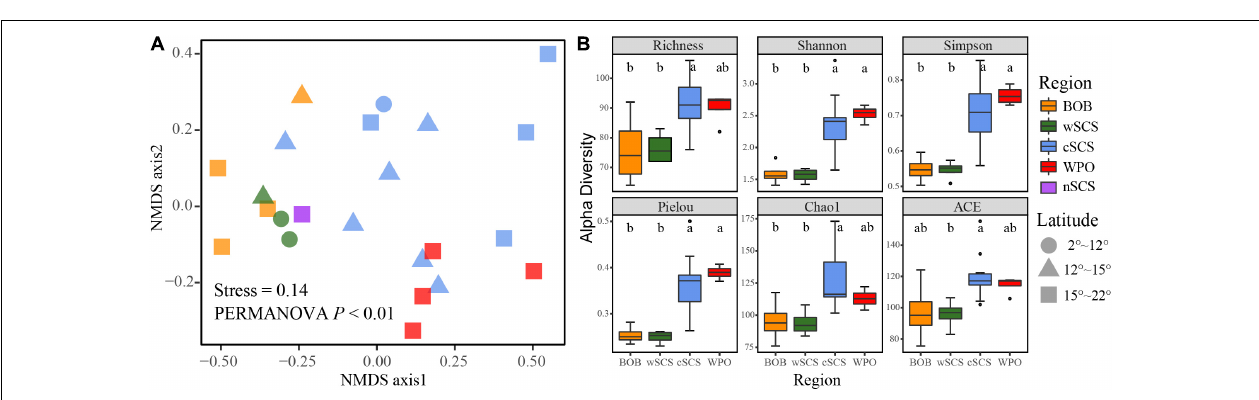
FIGURE 1 | The biogeography and diversity of UCYN-A in the BOB, SCS, and WPO. (A–C) are based on the amplicon dataset. (A) Phylogenetic relationship of dominant OTUs belonging to UCYN-A1, UCYN-A2, UCYN-A3, and UCYN-A4, respectively. The bootstrap supporting values above 50 are indicated with solid circles. (B) The relative abundance of these OTUs across different stations. (C) The regional distribution of UCYN-A OTUs according to the ternary plot. The size of circles is proportional to the relative abundance of corresponding sublineages. (D) Abundance of UCYN-A1 and UCYN-A2/A3/A4 in the tropical seas based on the qPCR results. The size of circles is proportional to the log-transformed abundance of UCYN-A. (E) The latitudinal constraint of UCYN-A abundance. Significant differences were determined from the output of non-parametric Kruskal–Wallis rank-sum tests ( ∗ p < 0.05; ∗∗ p < 0.01).